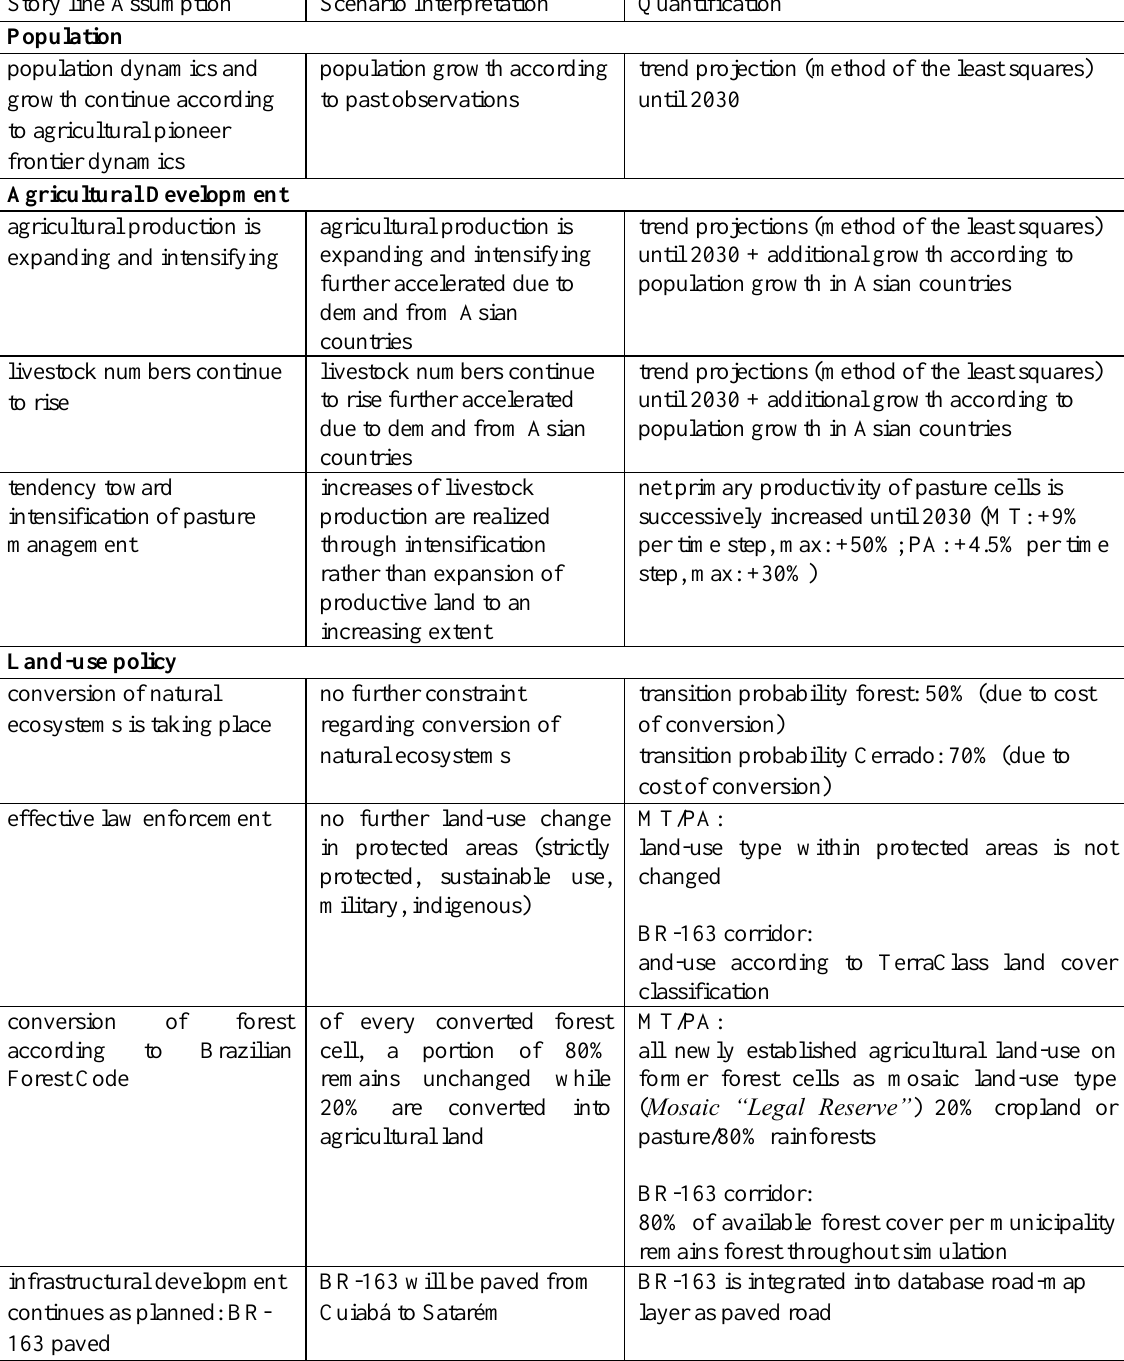
Table A1.2. Translation of story line statements to model drivers (Legal Intensification